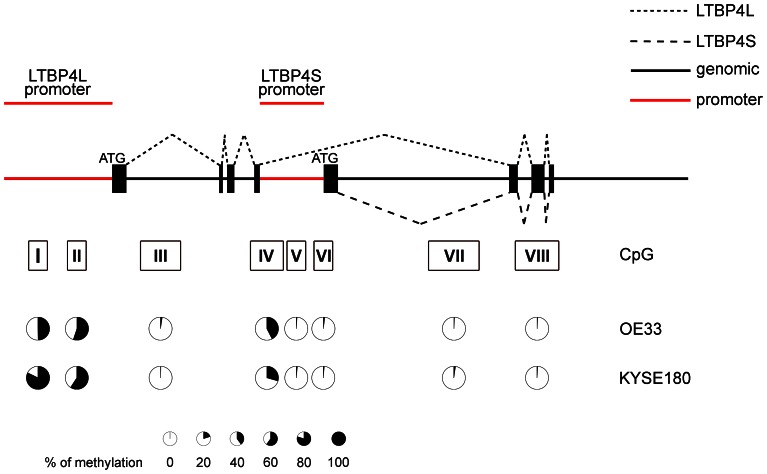
Methylation status of the two predicted LTBP4 promoter regions in esophageal carcinoma cell lines.The methylation status in the putative LTBP4 promoter regions was analyzed by clonal bisulfite sequencing in OE33 and KYSE180 cells. Eight CpG islands were identified and at least ten clones were sequenced for each cell line. The percentage of methylation in each CpG island is visualized as pie chart. Exons are illustrated by black boxes and LTBP4 promoters by red lines. The translation start sites are indicated (ATG). The dashed lines represent alternative splicing of LTBP4.